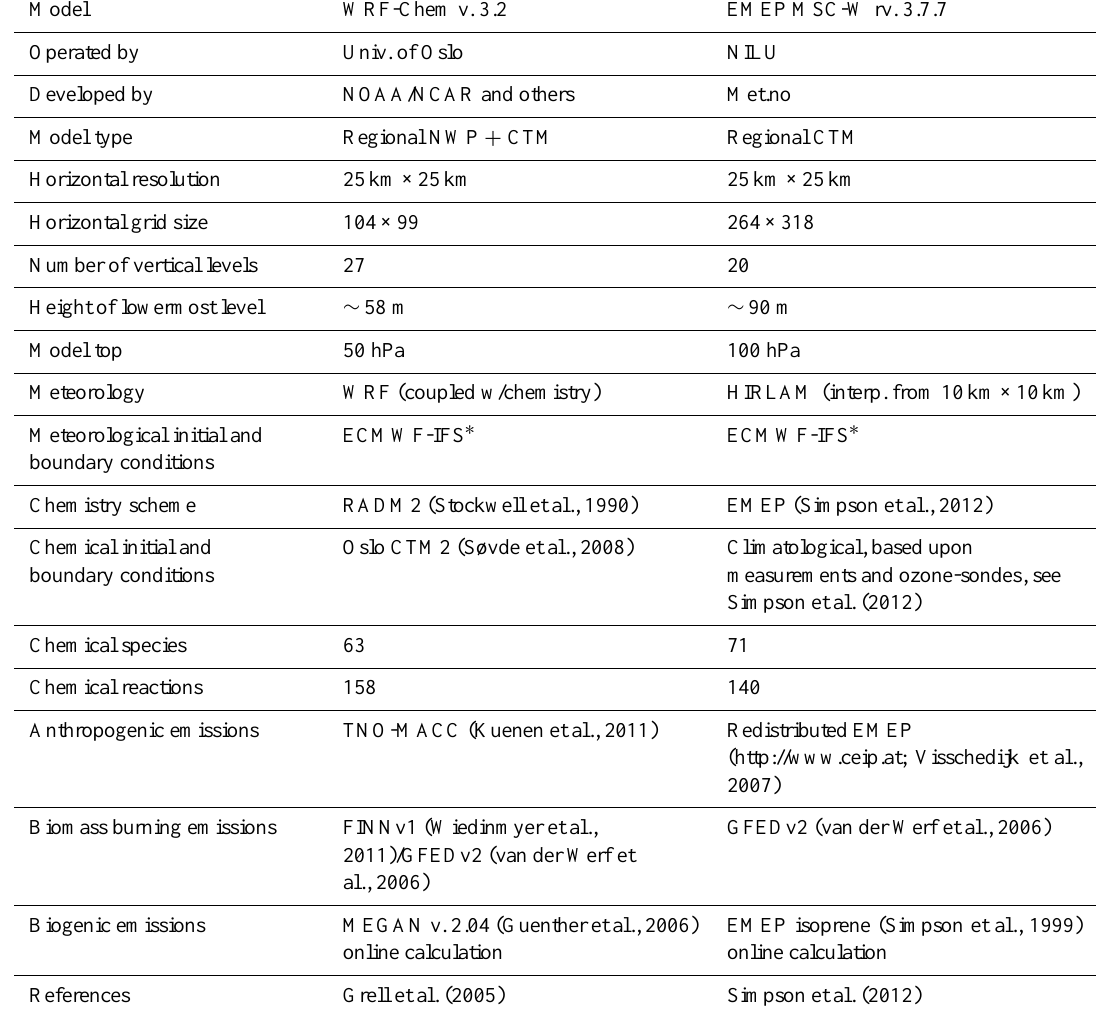
Table 1. Setups of the participating models; WRF-Chem and EMEP.